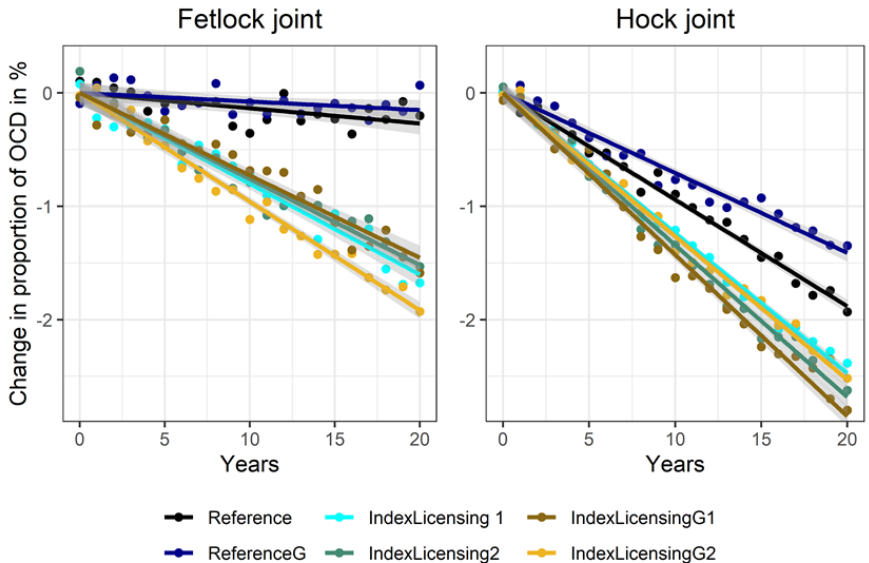
Figure 4. Proportion of unselected offspring with OCD in fetlock joints and hock joints for two reference scenarios and for four different scenarios including OCD in the breeding value estimation and in a selection index at the stage of stallion licensing.